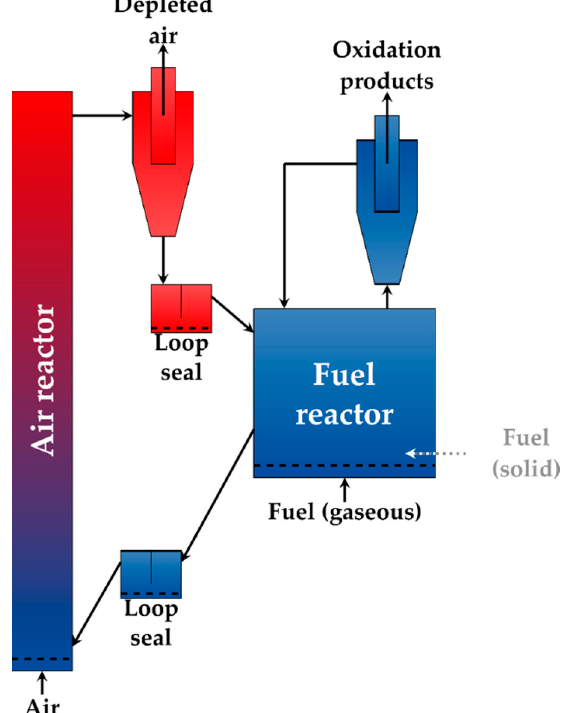
Figure 3. Scheme of a conventional circulating fluidized bed chemical looping reactor suitable for 245 chemical looping combustion. 246